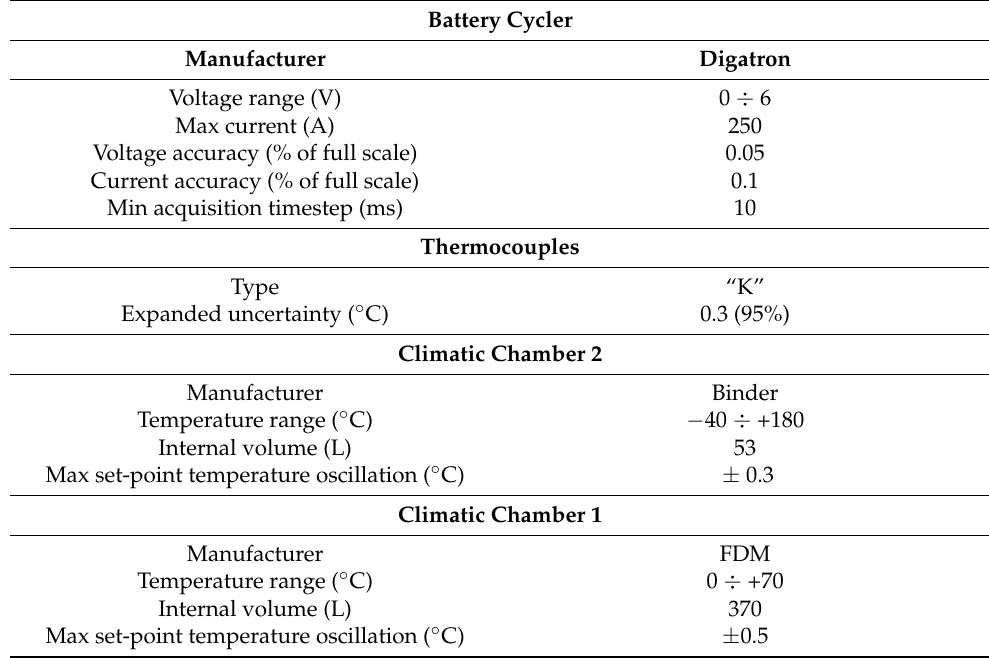
Figure A1. Battery laboratory of University of Pisa, DESTEC Department. Table A1. Laboratory instrument specifics.